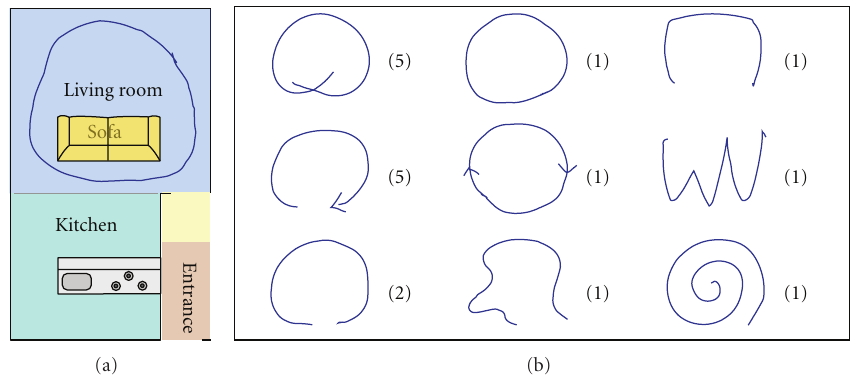
Figure 7: Sketch notations for locomotion within a region.